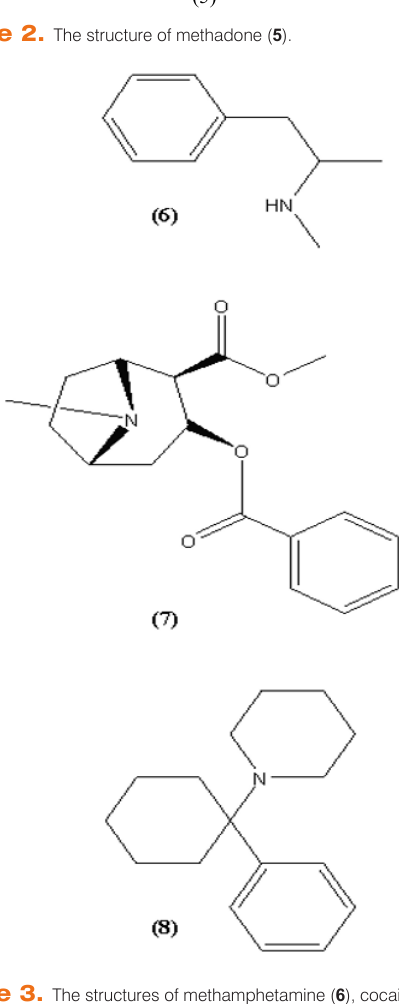
Figure 3. The structures of methamphetamine ( 6 ), cocaine ( 7 ) and phencyclidine ( 8